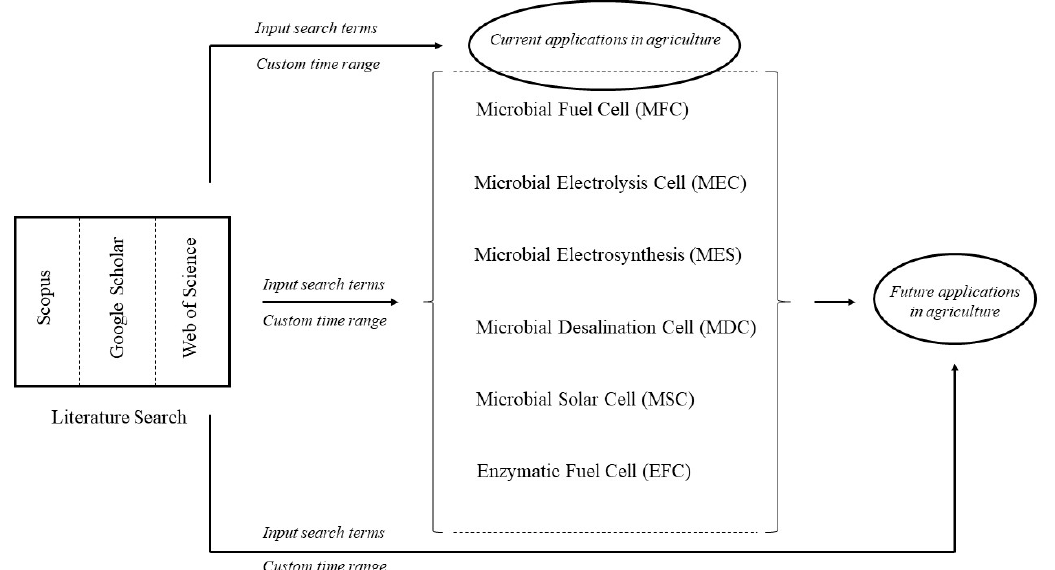
Figure 2. Rationale of methodology.